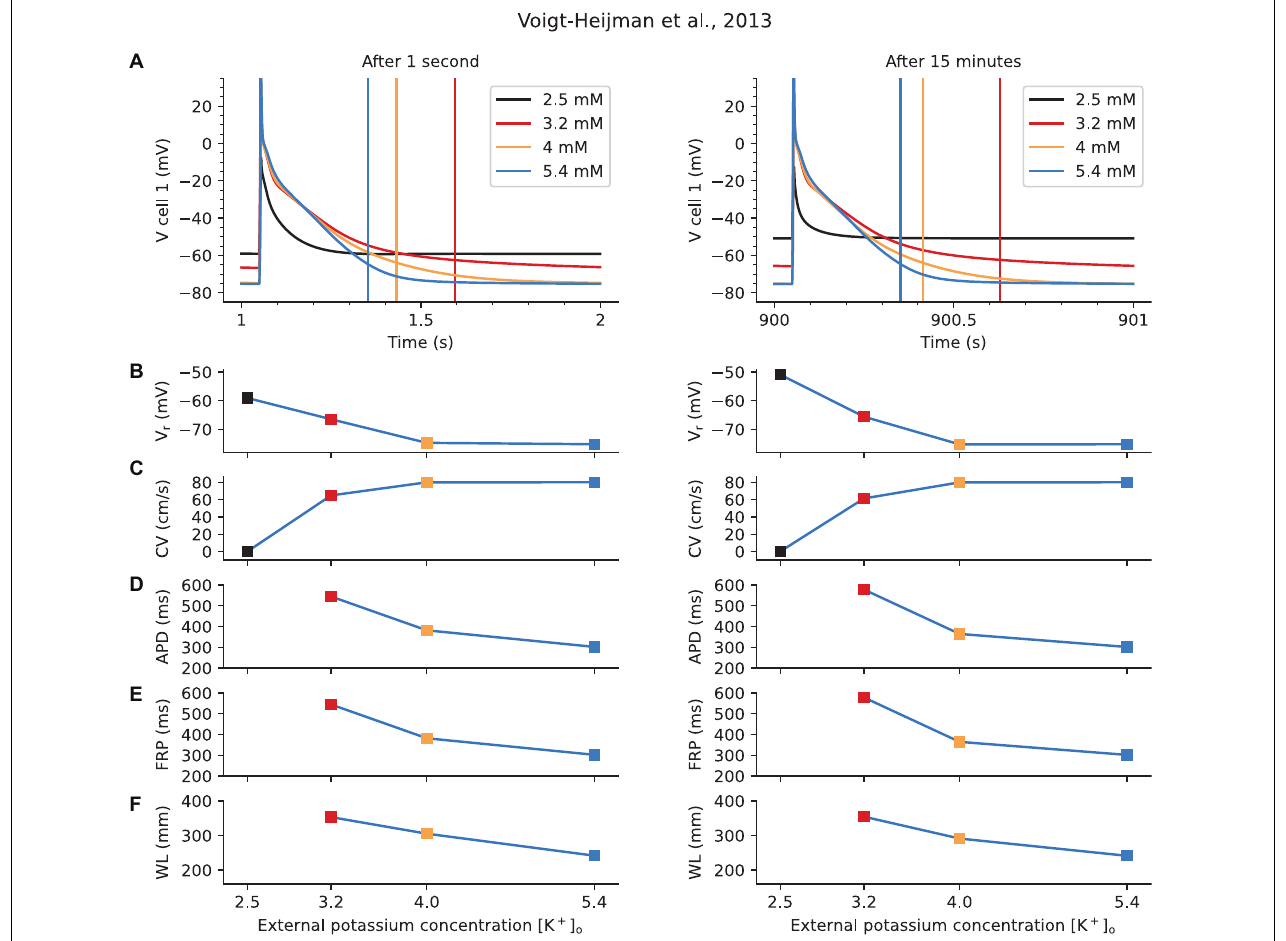
FIGURE 5 | Human Atrial Tissue “Strand” Model for Evaluation of Effects of Hypokalemia on Excitability, Conduction Velocity and Wave Length of Conduction. The Voigt-Heijman et al. model of the human atrial myocyte was used as the basis for constructing a 1-D, 200 myocyte atrial strand. Standard steady-state pacing and extra stimulus protocols (S 1 –S 2 ) were applied, and the results are shown either immediately (1 s) after altering [K + ] o or under quasi steady-state conditions (after 15 min). The separate panels in Row A show individual AP waveforms in the first myocyte in the simulated strand, at the [K + ] o levels that were the focus of this study. The vertical lines in these graphs indicate the functional refractory periods (FRP) that were estimated from the tissue strand response after either 1 s (left) or 15 min (right). These results, and the corresponding V r , CV, APD, and WL values are presented in Rows B–F below. Note that in 2.5 mM [K + ] o the small AP failed to support conduction, and so no APD, FRP, or WL could be determined. See section “Results” for more